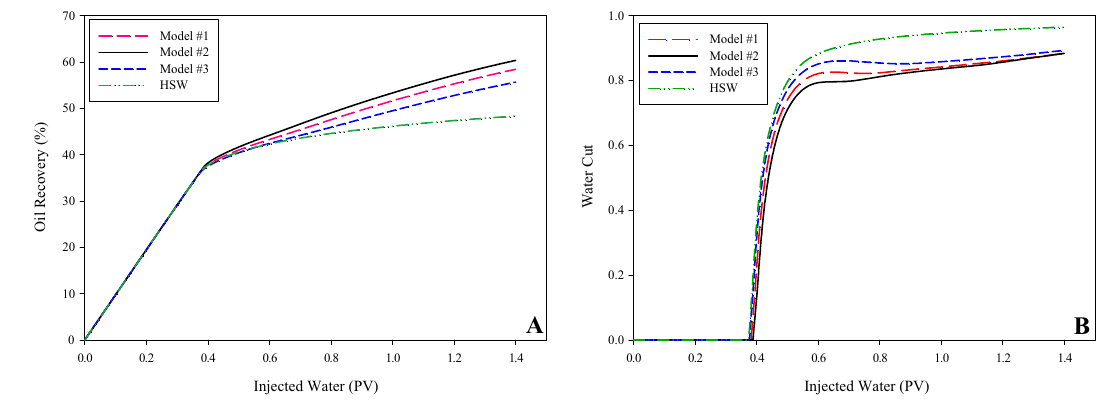
Fig. 7 Effect of salinity threshold and weighting coefficient on a LSW oil recovery, and b well water